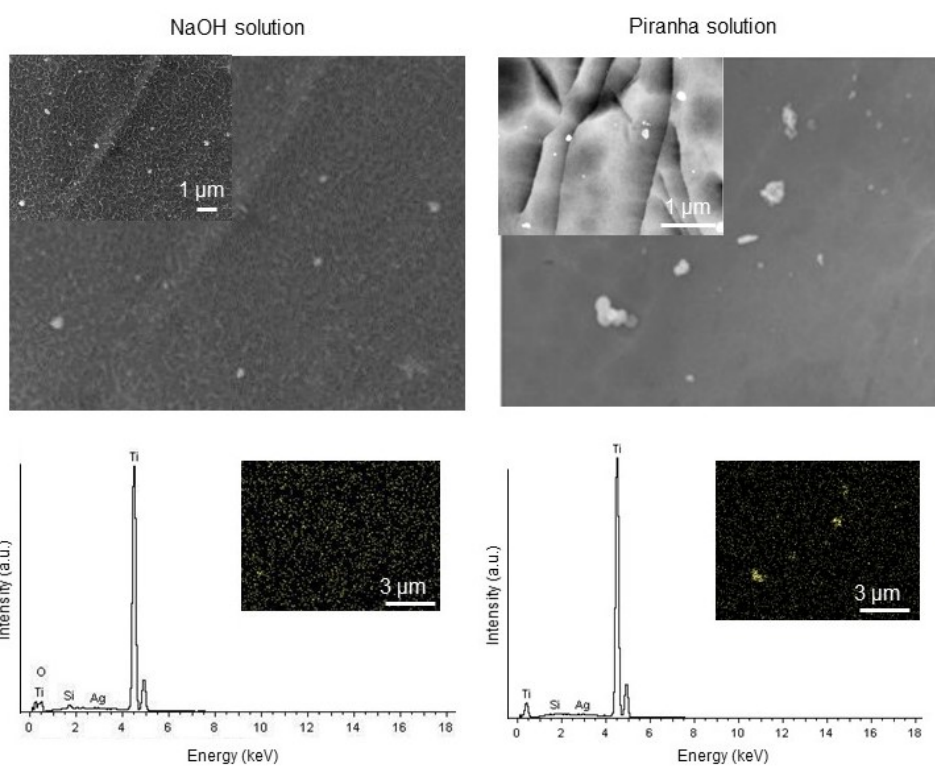
Figure 5. SEM micrographs and EDS-SEM of fully dense Ti substrates, treated with NaOH (left), or piranha (right), and after coating with AgNPs via a “submerged” reduction in both cases.